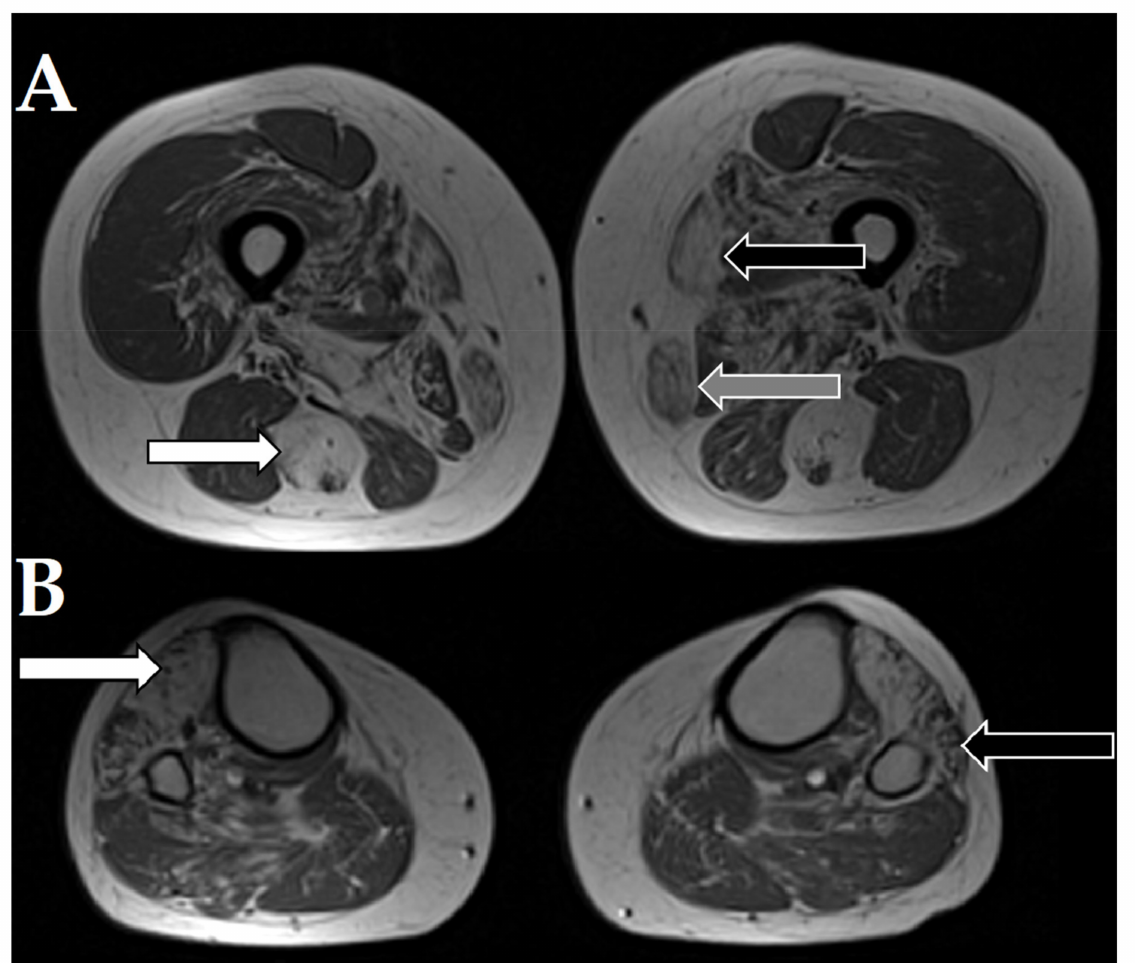
Figure 3. Magnetic resonance imaging of selected axial T1W images of muscles of the patient 1a with desminopathy. ( A ). White arrow points to severe fatty atrophy in the semitendinosus muscle. Black arrow points to the sartorius muscle. Grey arrow points to the gracilis muscle. ( B ). White arrow points to severe changes in the tibialis anterior muscle. Black arrow points to the affected peroneus